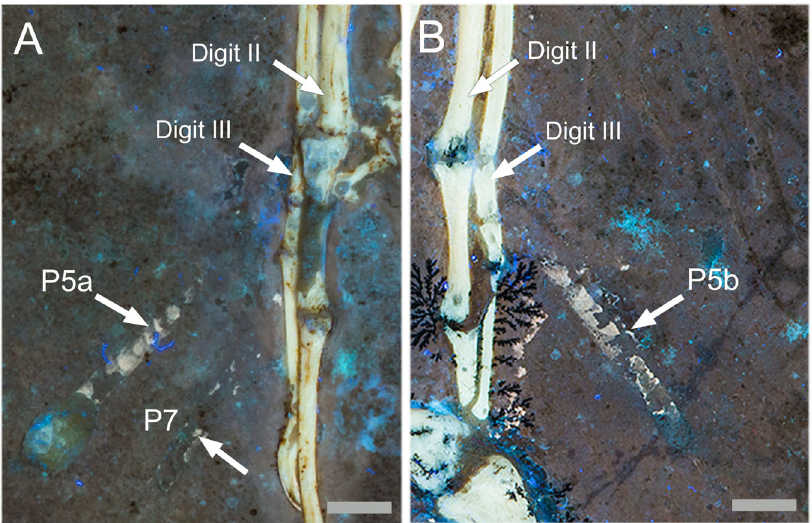
Fig. 3 Close up of the hands of WDC-CSG-100 under LSF showing the position of the bilaterally symmetrical corni fi ed feather sheaths. a Arrow P5a is the feather sheath on the fi fth right primary feather. Arrow P7 shows remnants of the third sheath on the seventh primary feather. The sixth primary feather has already molted out and the molt sequence is proceeding in two opposite directions. b Arrow P5b points to the feather sheath on the fi fth left primary feather which matches the one preserved on the right hand (arrow P5a). Scale bars are 0.5